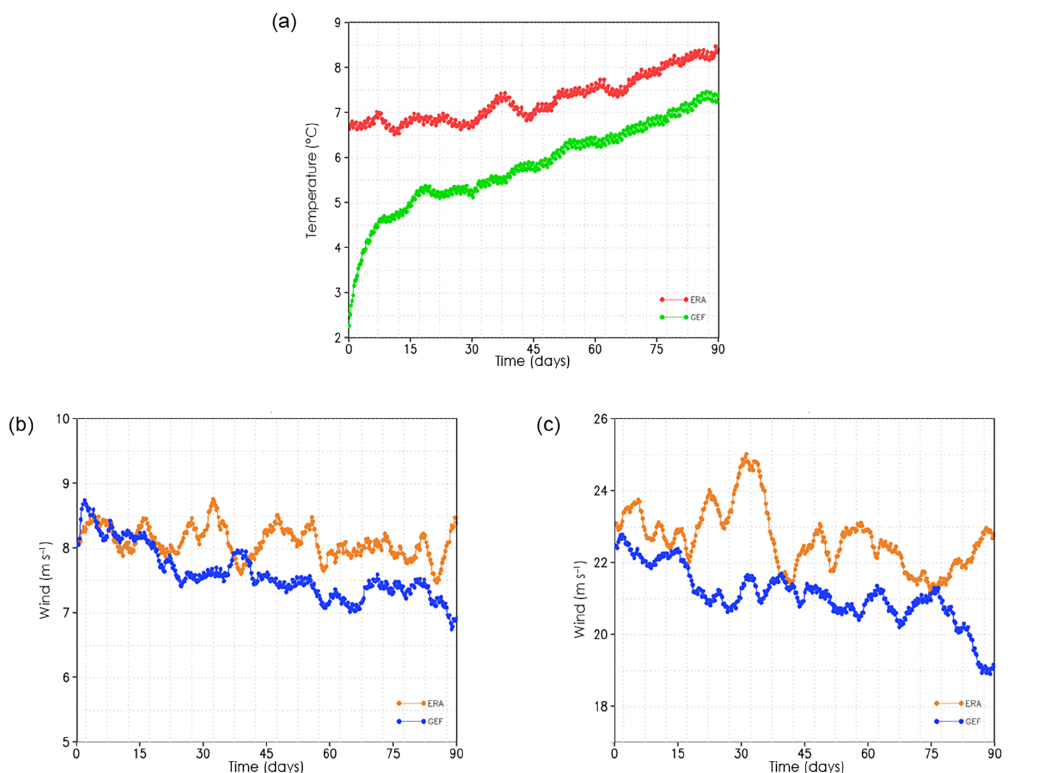
Figure 3. February to April (FMA) 1996 time series of global mean variables from ERA-Interim reanalyses and simulated by GEF: (a) 850hPa temperature ( ◦ C) (the green curve is GEF and the red curve is the reanalysis) and (b) 850hPa wind (ms − 1 ), and (c) 200hPa wind (ms − 1 ) (the blue curves are GEF and the brown curves are the reanalyses).